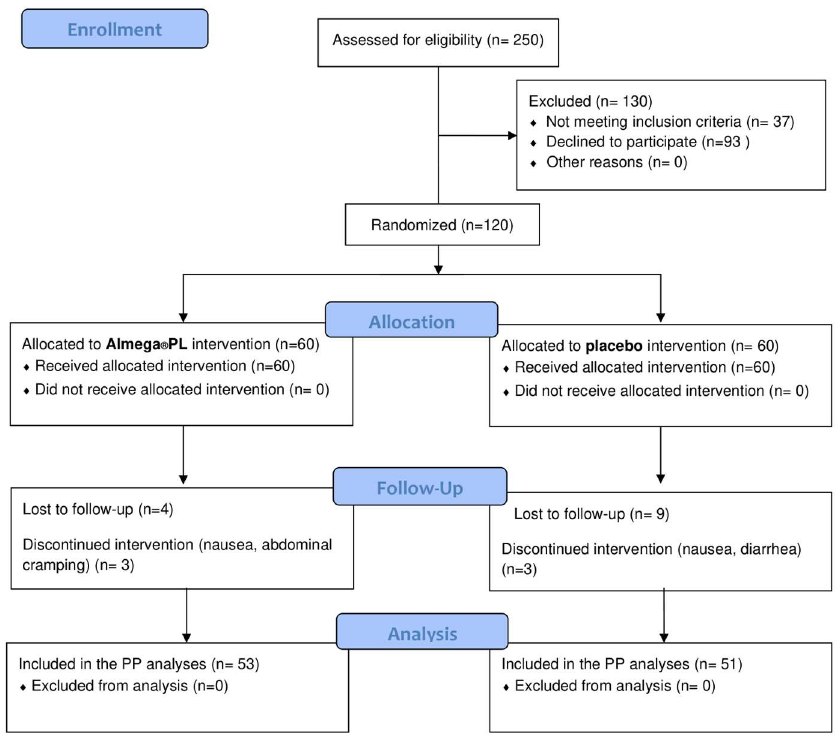
Figure 1. A total of 120 participants were randomized to receive Almega ® PL or placebo treatment. Study completers ( n = 104) included participants who completed the week 12 visit. Participants who dropped out were not included in the statistical analysis.